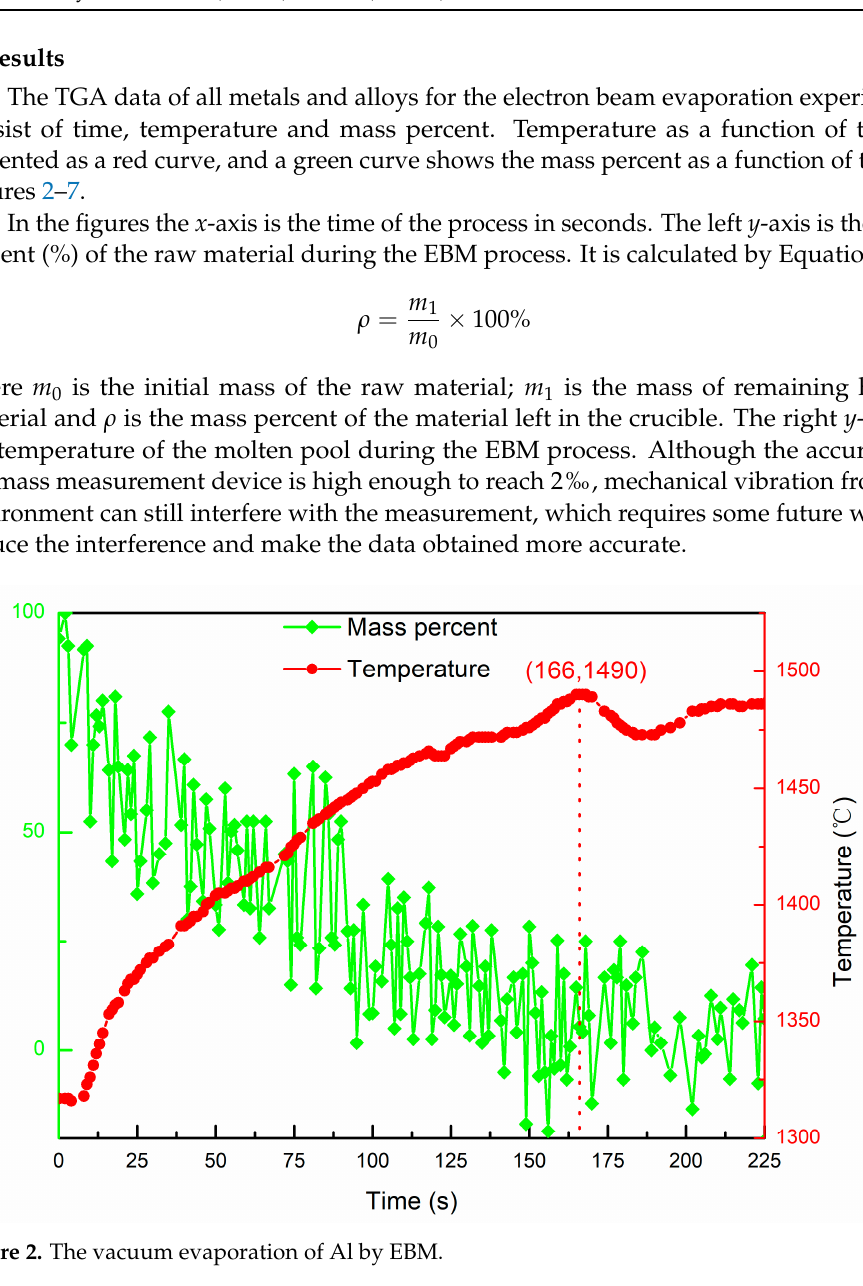
Table 3. Electron beam power and average heating and cooling rates in the experiment.